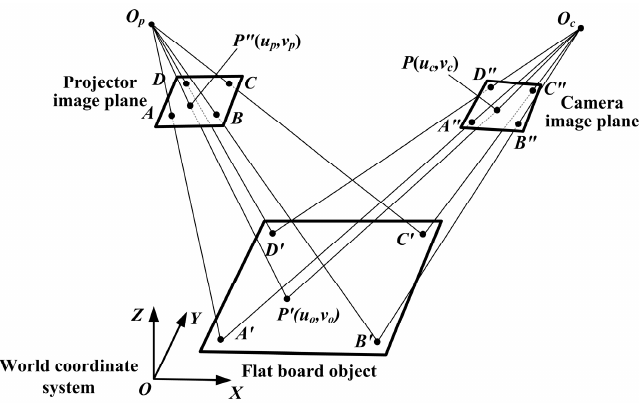
Figure 6. Planar projective transformation between projector and camera image planes.